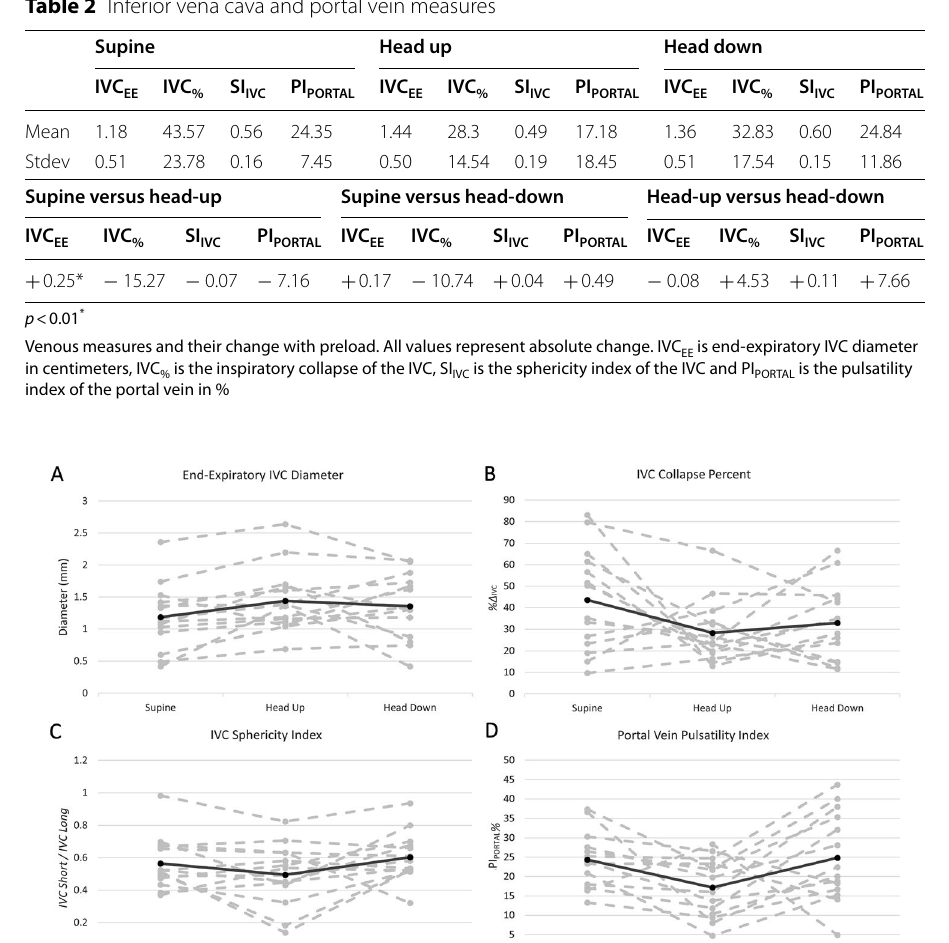
Table 2 Inferior vena cava and portal vein measures